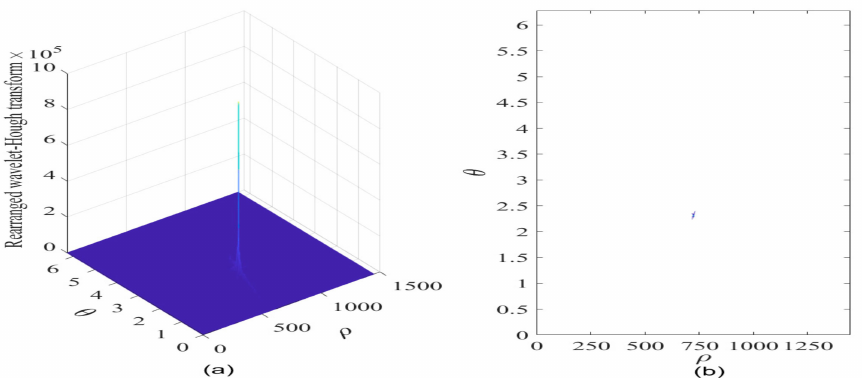
Figure 15. The rearranged Wavelet–Hough transform of the GPS L1-C/A signal in the presence of continuous wave interference. C / N 0 = 40 dB-Hz, JNR = − 2 dB. ( a ) Rearranged Wavelet–Hough transform; ( b ) Contour of rearranged Wavelet–Hough